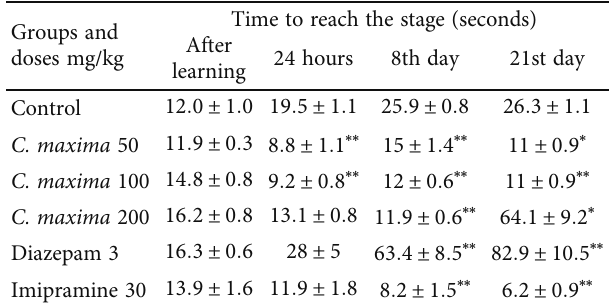
Table 5: E ff ect of C. maxima seed extract on motor skilled learning and memory (stationary